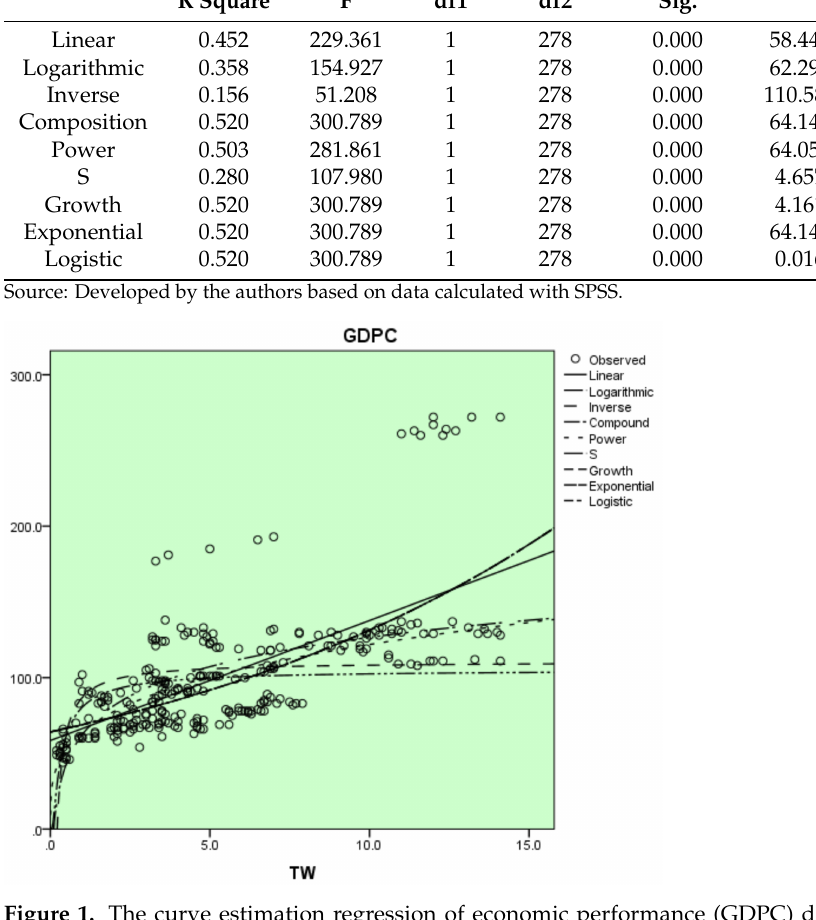
Figure 1. The curve estimation regression of economic performance (GDPC) depending on the telework (T.W.). Source: Developed by the authors based on the calculated data in